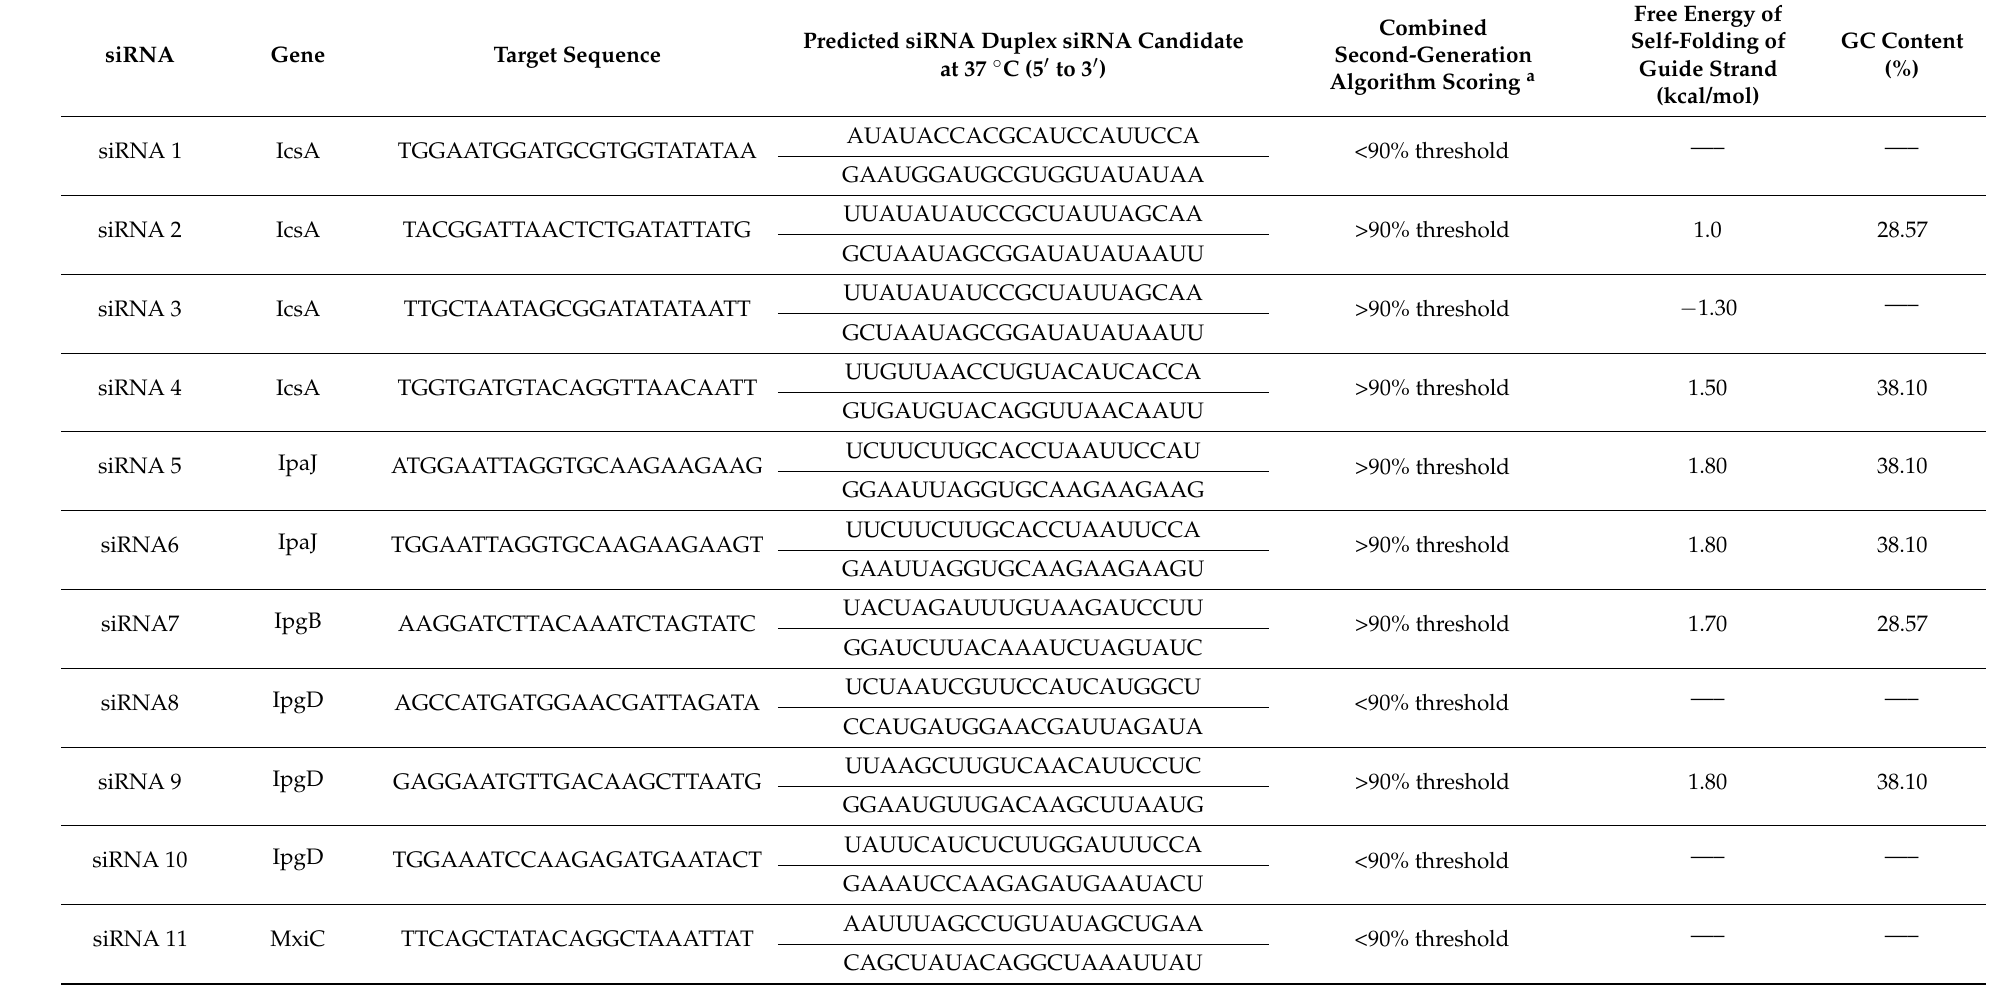
Table 2. Effective siRNA candidates for each of the conserved virulence-associated Shigella genes as analyzed by both the first-generation and second-generation algorithms for designing siRNAs along with their respective free energy of folding and GC content. Free Energy of Combined Predicted siRNA Duplex siRNA Candidate Self-Folding of siRNA Gene Target Sequence Second-Generation at 37 ◦ C (5 (cid:48) to 3 (cid:48) ) Guide Strand Algorithm Scoring a